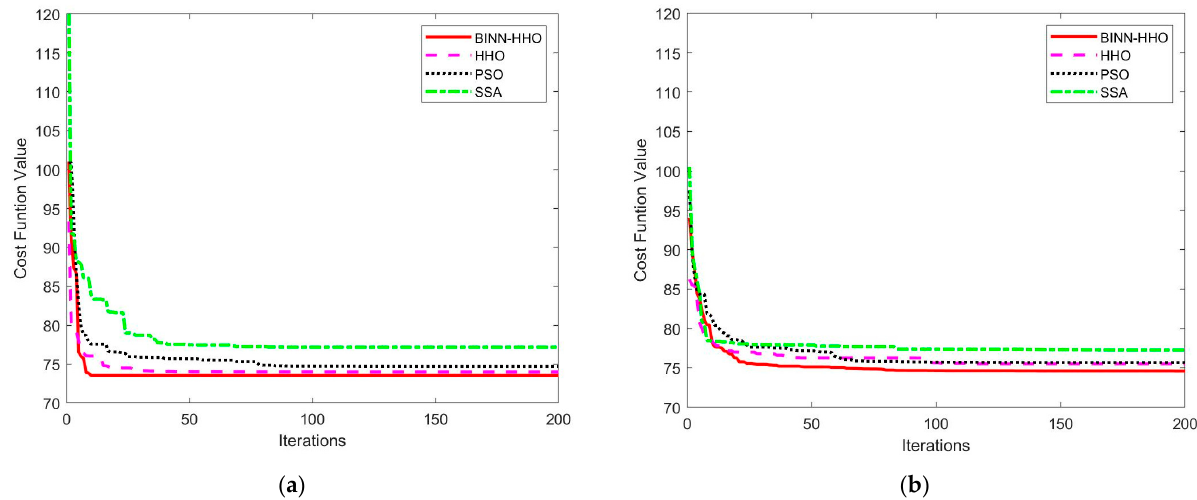
Figure 13. Evolution curves of cost function values in a dynamic environment. ( a ) Dynamic case I. ( b ) Dynamic case